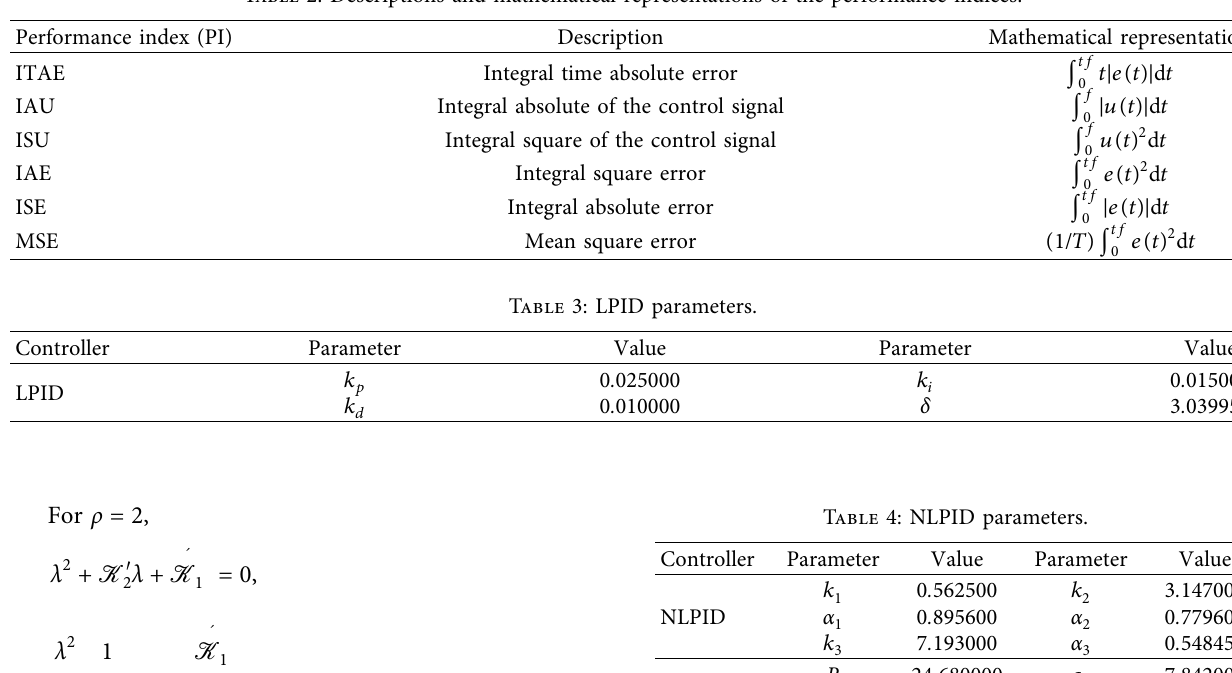
Table 2: Descriptions and mathematical representations of the performance indices.